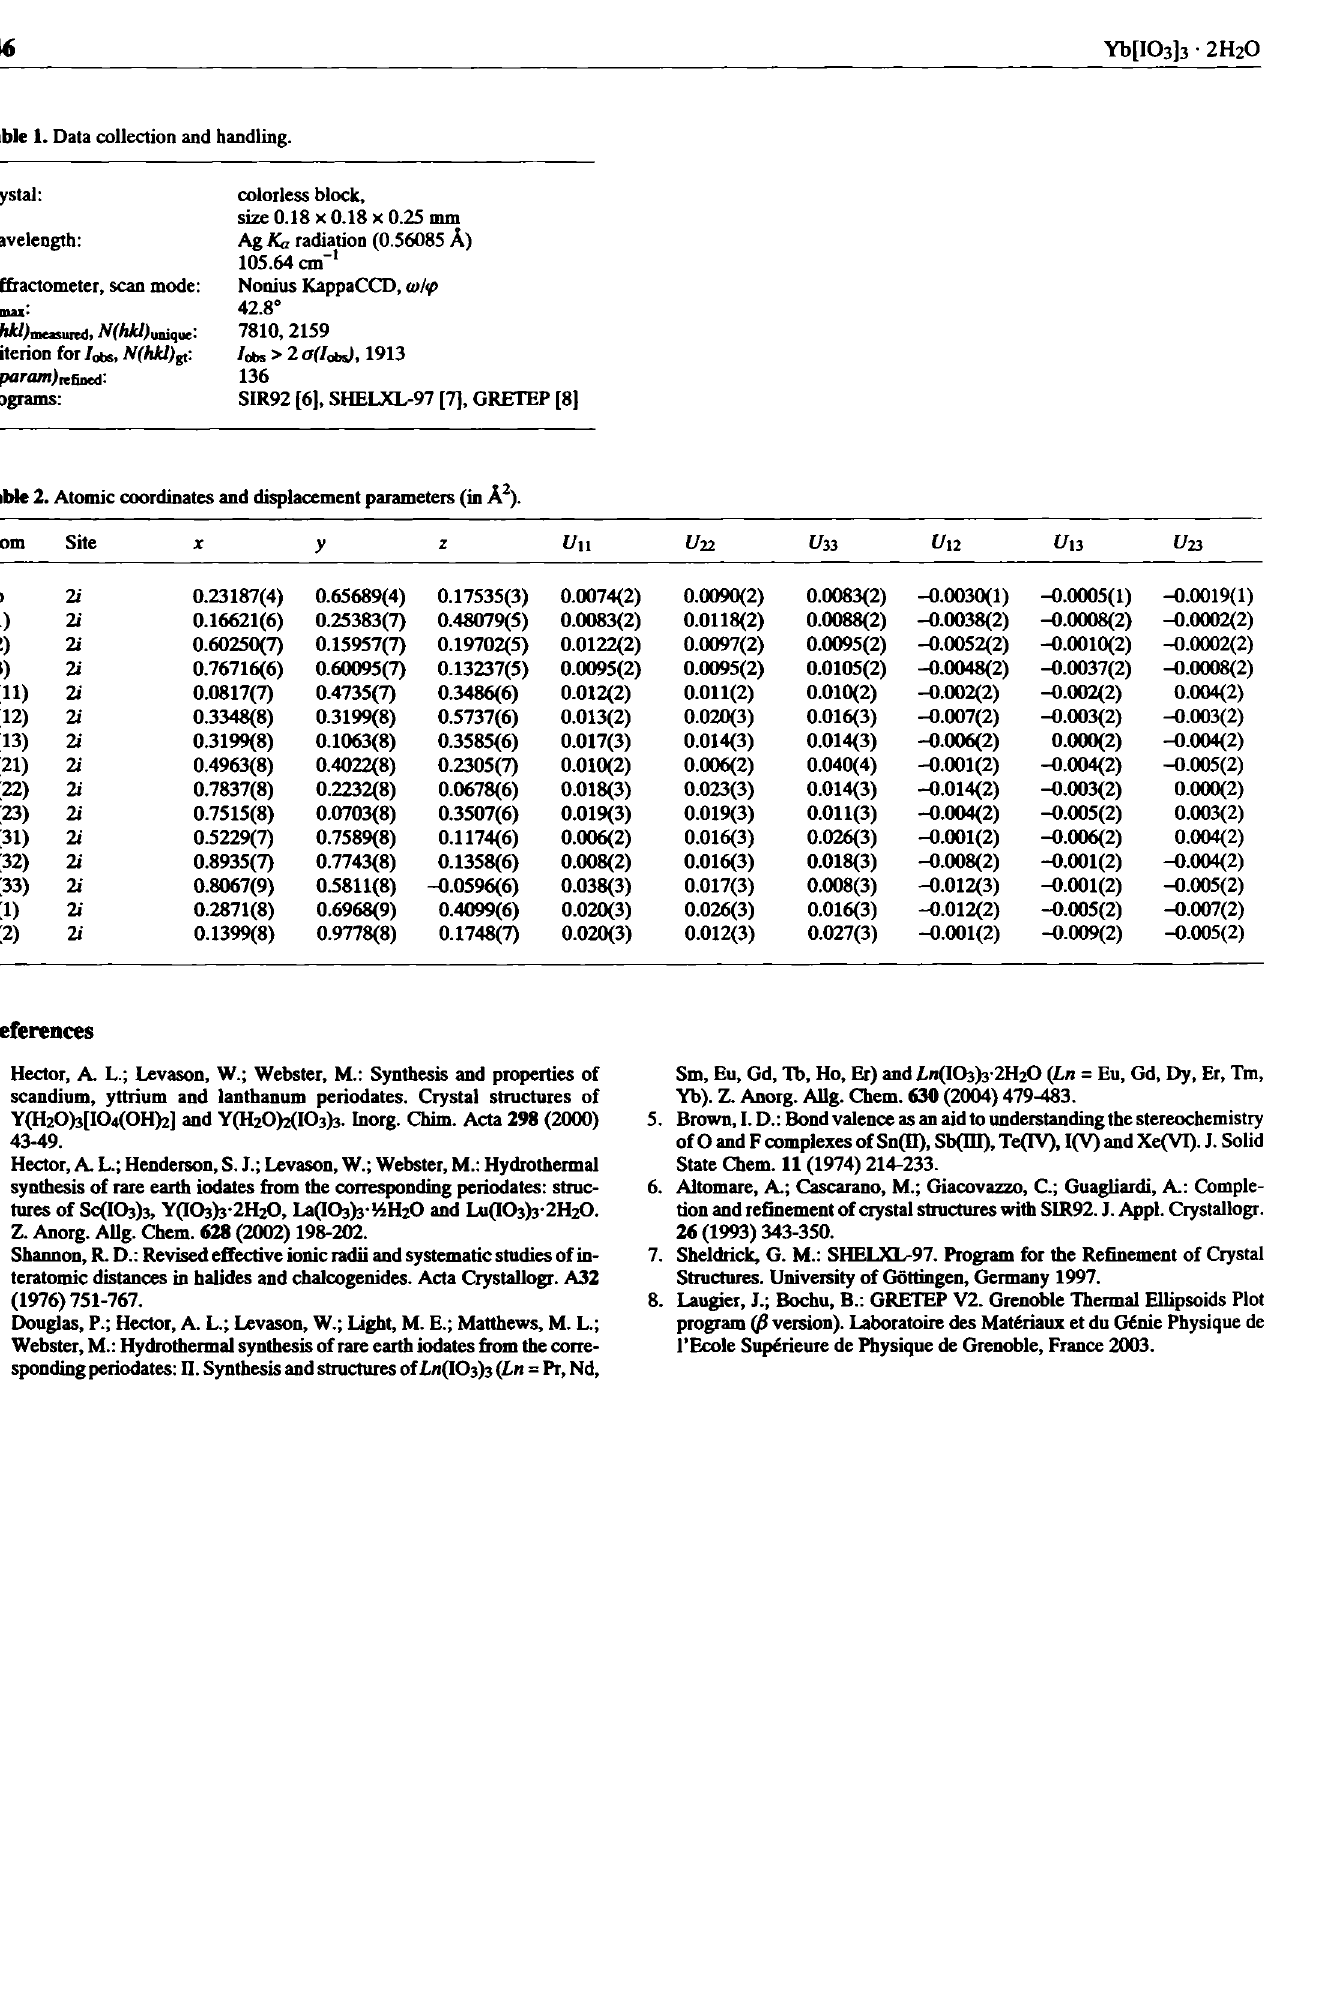
Table 1. Data collection and handling.